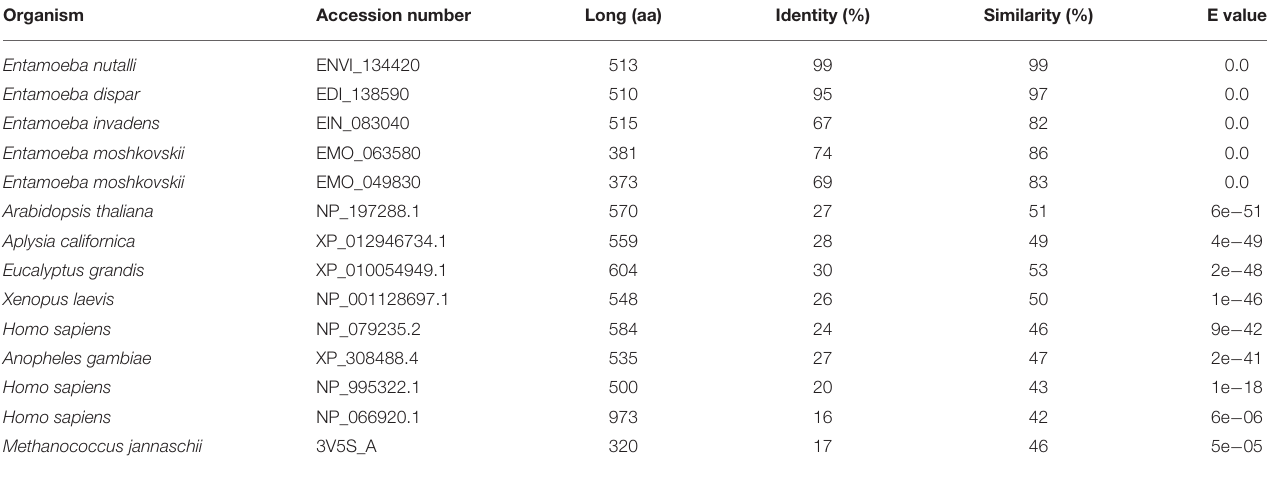
TABLE 1 | Comparison of the calcium/sodium exchanger of E. histolytica with orthologous proteins of different organisms.